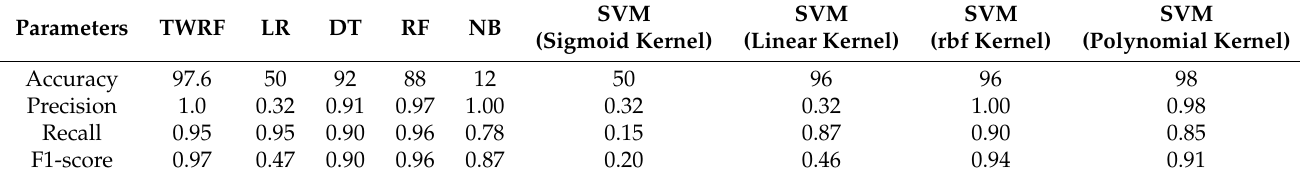
Table 4. Performance analysis of different machine learning algorithms for the proposed